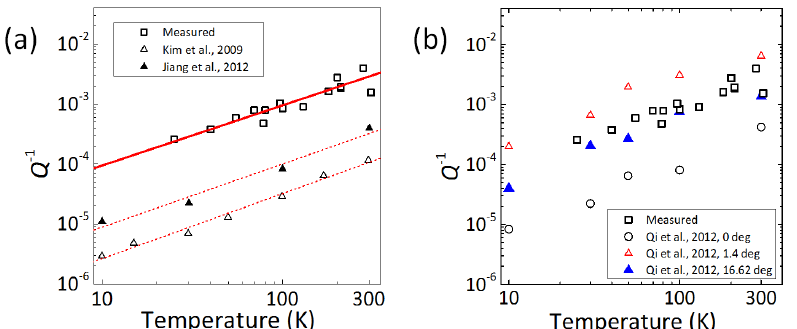
Figure 7. (Color online) ( a ) Energy dissipation ( Q − 1 ) as a function of temperature in drumhead monolayer graphene resonators. Our measured data are shown as open squares. Solid triangles and open triangles are the quality factors estimated by the numerical analysis for the circular resonator with constrained edges from [6] and for the rectangular-shaped resonator with the periodic boundary condition from [7], respectively. Red solid and dashed lines show linear fittings. ( b ) Variation of energy dissipation ( Q − 1 ) as a function of temperature in drumhead monolayer graphene resonators. Our measured data (open squares) are compared with calculated data in [14] for the resonators under 1% strain without grain boundaries (open circles) and with a single grain boundary with misorientation angles of 1.4 ◦ (red open triangles) and 16.62 ◦ (blue solid triangles). Reproduced from [12], with the permission of AIP